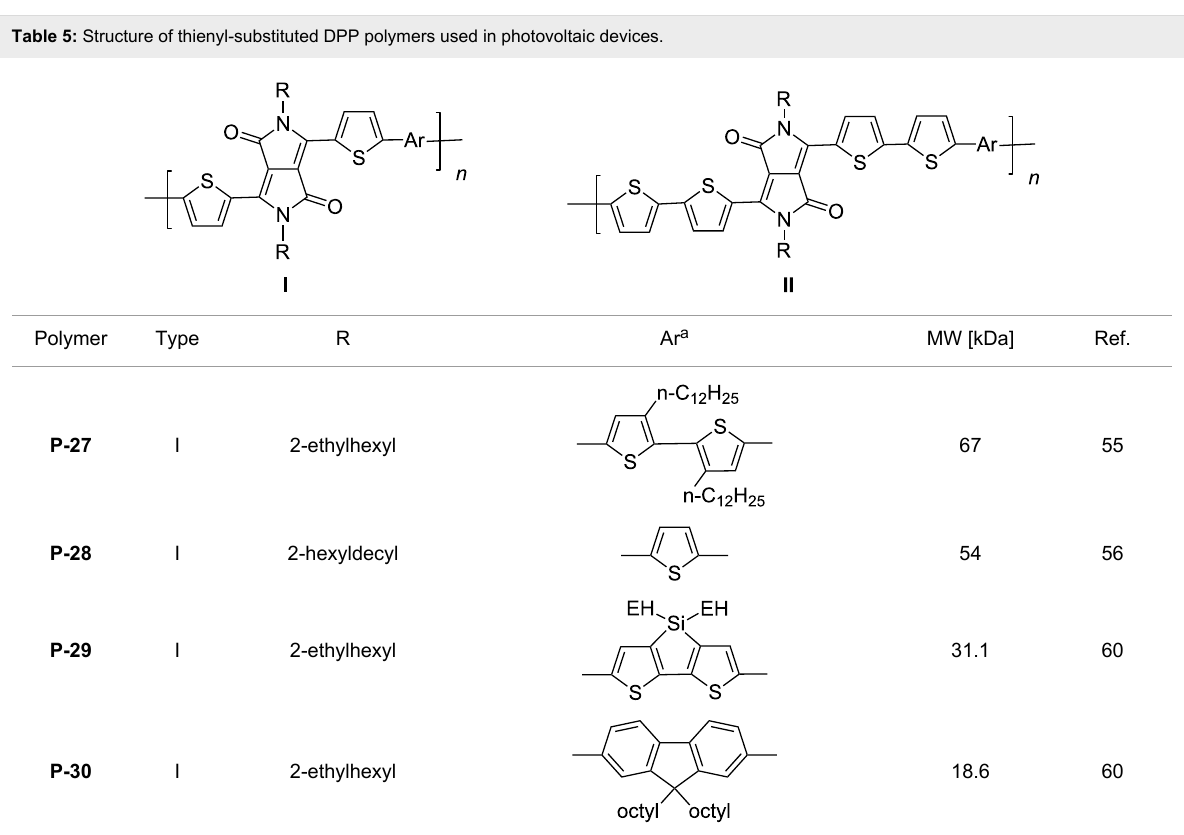
Scheme 3: Thiophenyl-DPP-based polymers.